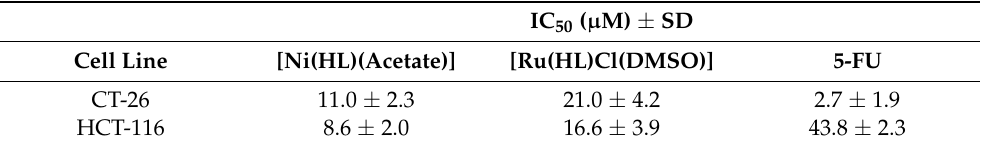
Figure 8. In vitro antiproliferative activity of [Ni(HL)(acetate)], [Ru(HL)Cl(DMSO)] and 5-FU against CT-26 ( A ) and HCT-116 ( B ) colon cancer cells after 48 h incubation. Table 5. Half-inhibitory concentration (IC 50 ) of [Ni(HL)(acetate)], [Ru(HL)Cl(DMSO)] and 5-FU towards human and murine colon cancer cell lines, after 48 h incubation.